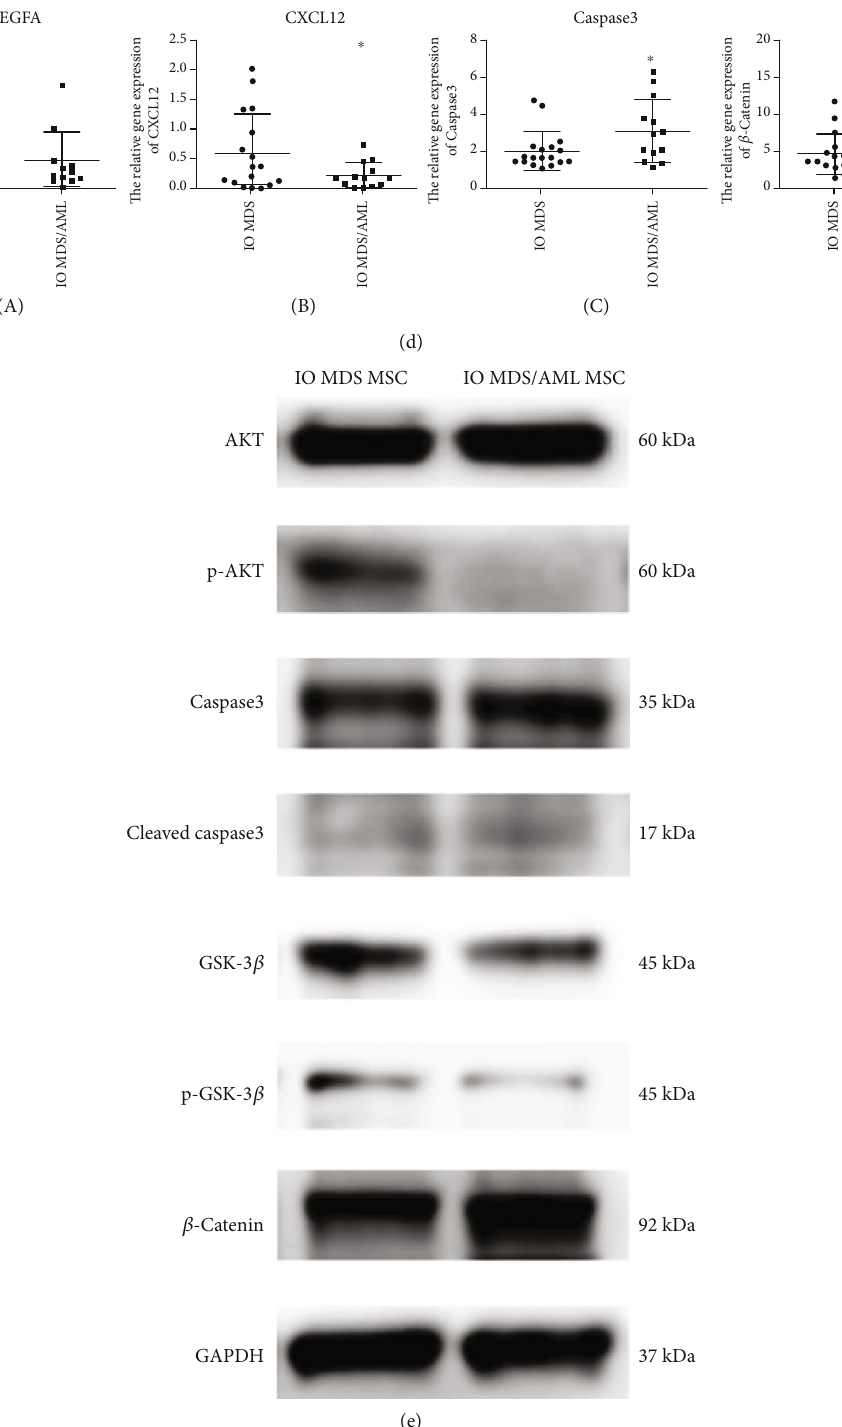
Figure 4: The characteristics and functions of MSCs between IO MDS and IO MDS/AML patients. (a) There was no di ff erence in morphology of MSCs between IO MDS and MDS/AML patients. (b) The level of ROS in the IO MDS/AML group was signi fi cantly higher than that in the IO MDS group ( p < 0 : 05 ). (c) The apoptosis of MSCs in the IO MDS/AML group was signi fi cantly higher than that in the IO MDS group. (d) The gene expressions of caspase3 and β -catenin in MSCs in the IO MDS/AML group were signi fi cantly upregulated compared with those in the IO MDS group, with a signi fi cantly downregulated gene expression of CXCL12. (e) The protein levels of p- AKT and GSK-3 β in the IO MDS/AML group were downregulated, with upregulated protein levels of caspase3 and β -catenin. Compared with the IO MDS group: ∗ indicates p < 0 : 05